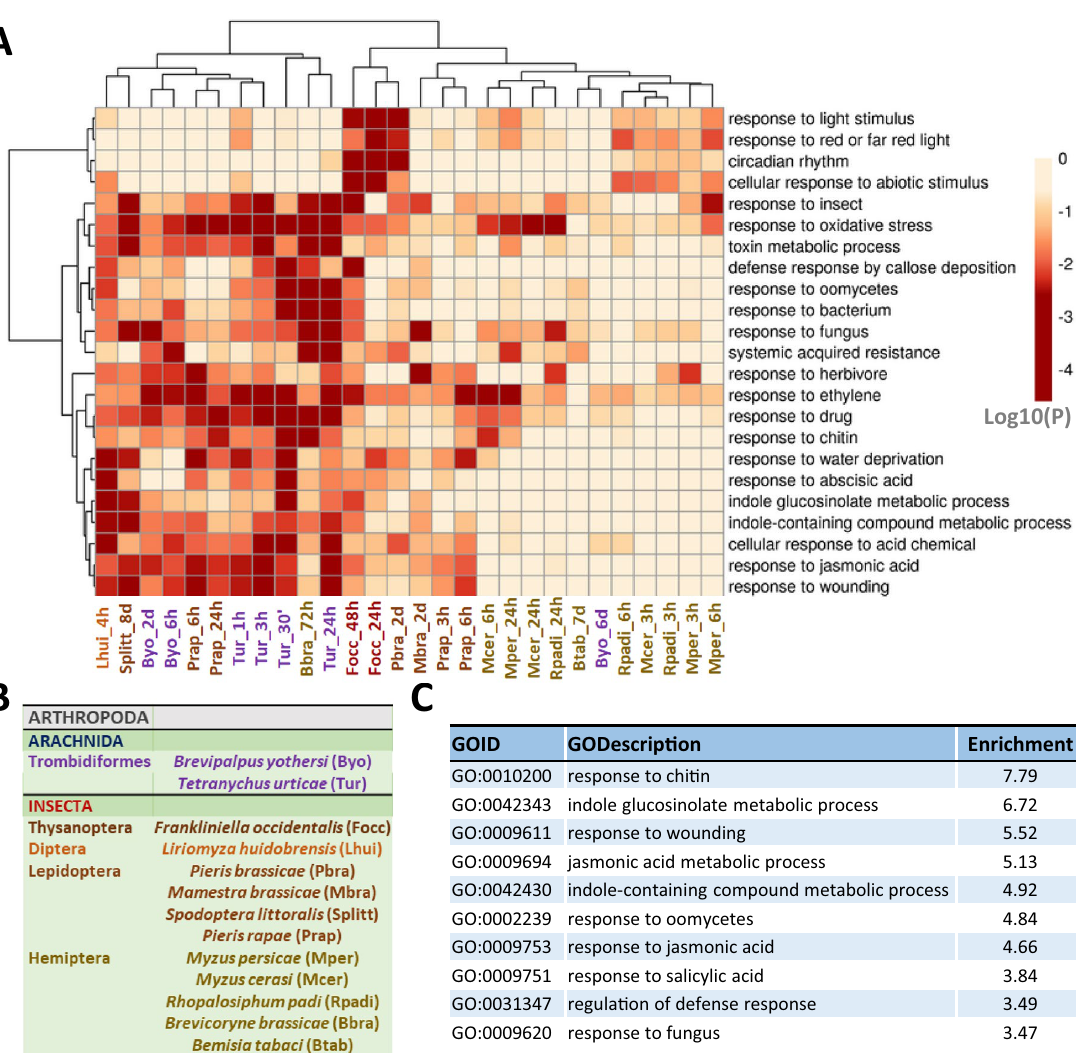
Figure 1. Meta-analysis of the transcriptomics experiments. ( A ) Heatmap showing the significance of the most enriched biological ontologies. ( B ) Taxonomic classification of the arthropods used in the experiments. ( C ) List of the top 10 enriched biological processes obtained from a single list of all the DEGs merged